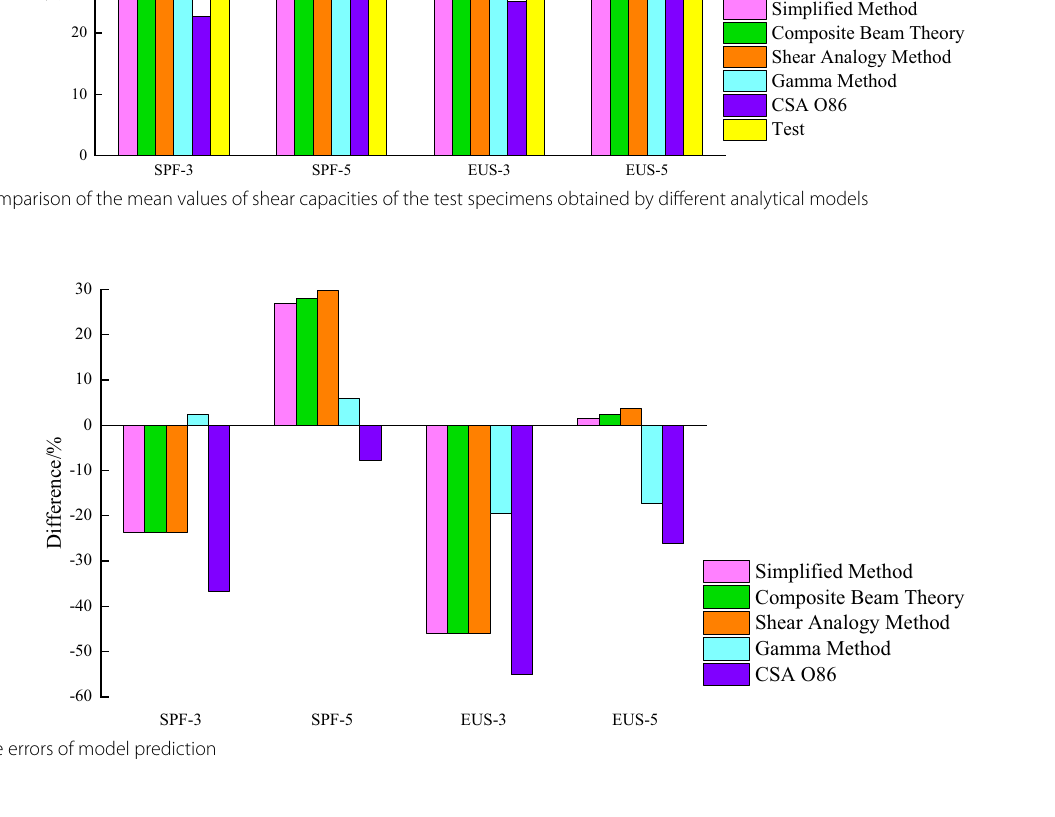
Table 4 Comparation of prediction rolling shear capacity with test